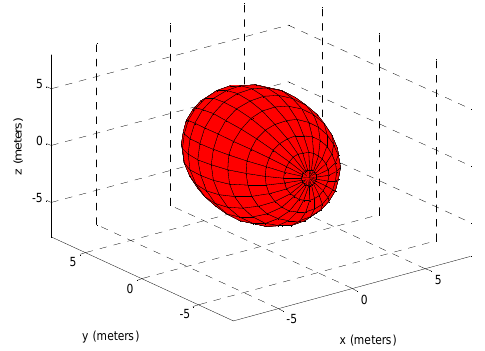
Figure 13. Predicted 0.9p error ellipsoid (70% temporal correlation)